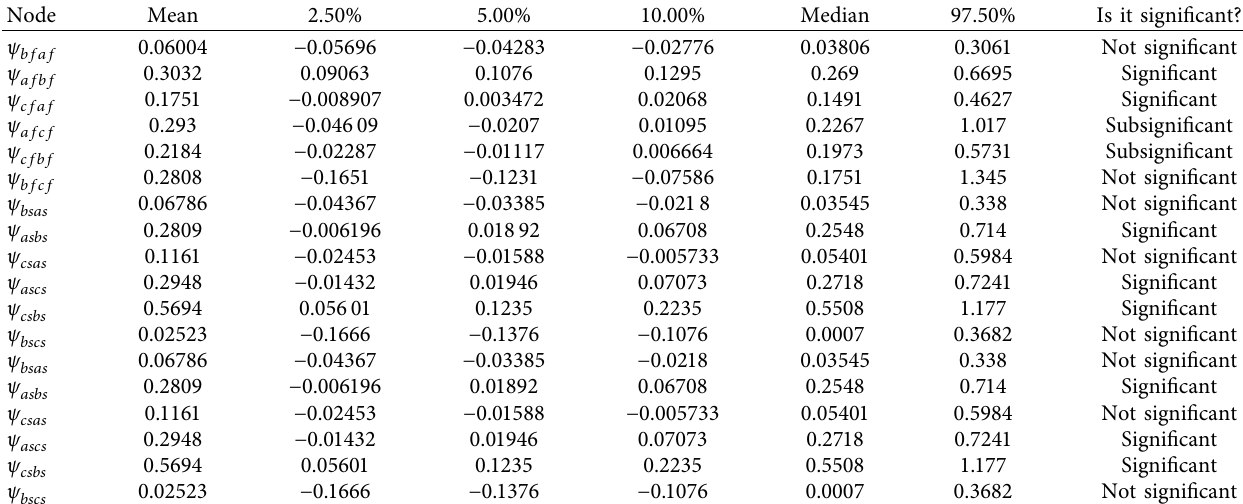
Table 4: Volatility spillover parameter estimation result of different oil markets.